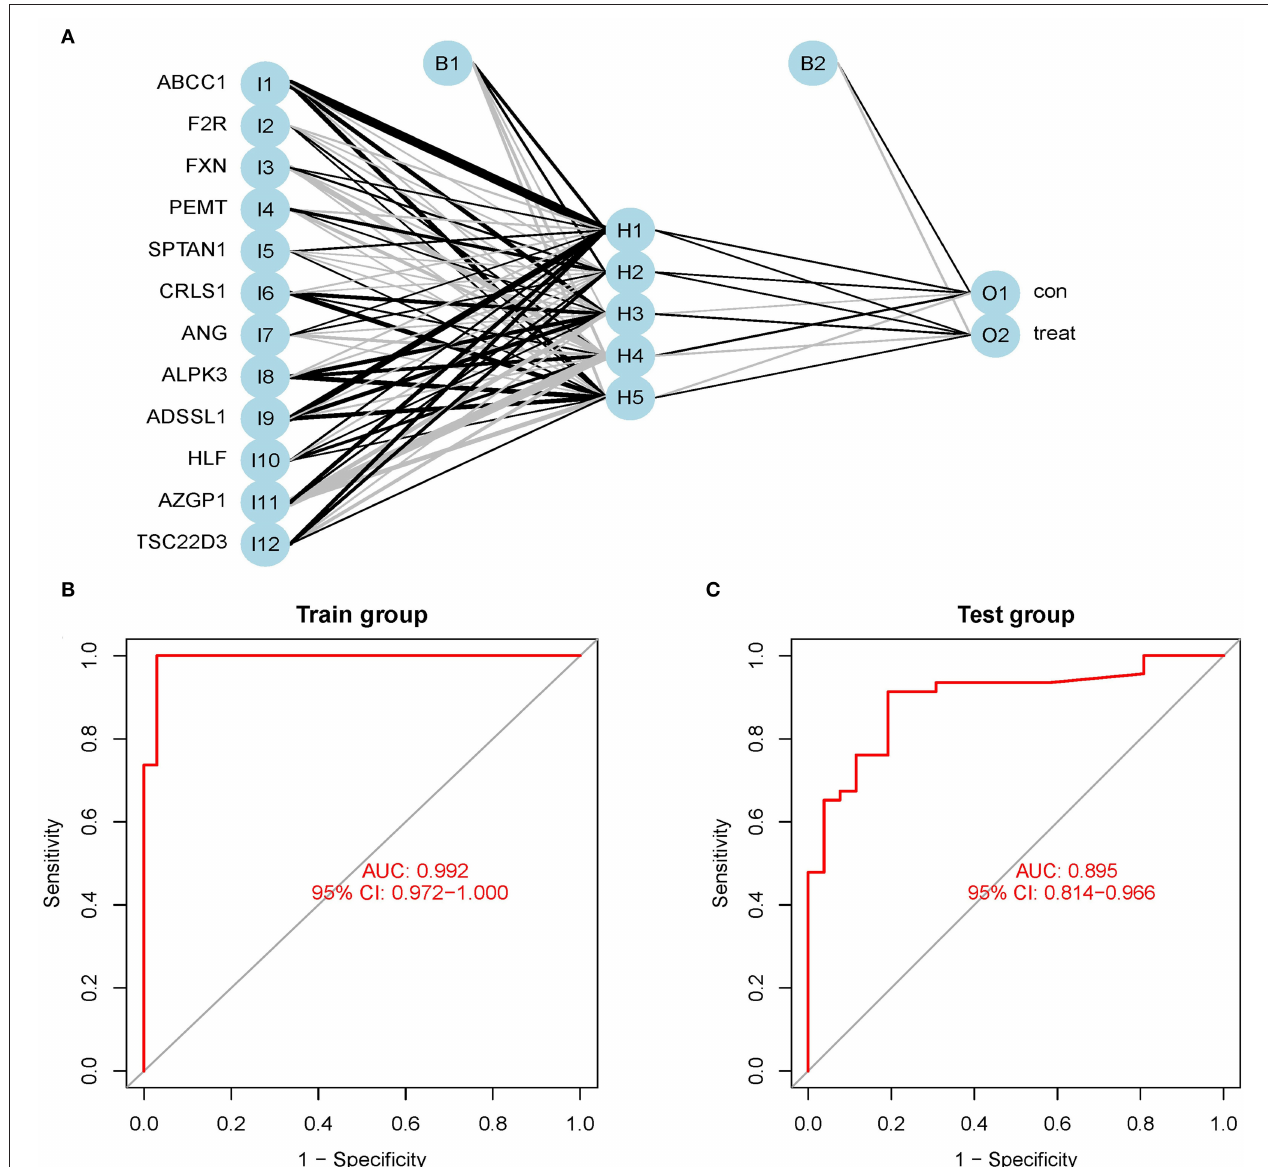
FIGURE 6 | (A) Neural network visualization results. (B) The training group verifies the ROC curve findings (merge dataset of GSE24881 and GSE25403). (C) The testing group verifies the ROC curve findings (merge dataset of GSE156906 and GSE159924).